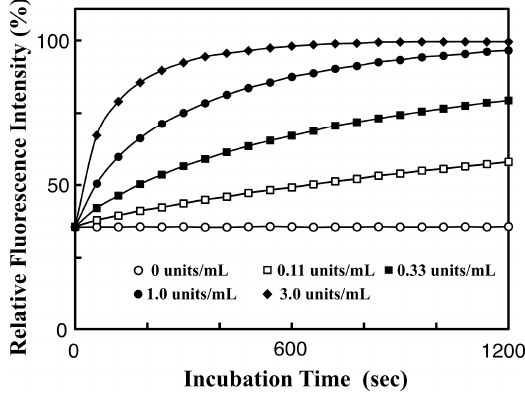
Figure 4. Time course change of the 580-nm fluorescence intensity ( λ ex = 523 nm) of an aqueous solution (pH 7.4, 3.0 mL) containing 2.5 µM TAMRA-Phos-tag and 2.5 µM TAMRA-PEA, 0.10 mM MgCl 2 , 0.10 M NaCl, and 10 mM Hepes-NaOH at 25 °C in the absence or presence of bovine intestinal mucosa alkaline phosphatase: 0 units/mL (open circles), 0.11 units/mL (open squares), 0.33 units/mL (closed squares), 1.0 units/mL (closed circles), or 3.0 units/mL (closed diamonds). The typical data are plotted with a time interval of 60 seconds.